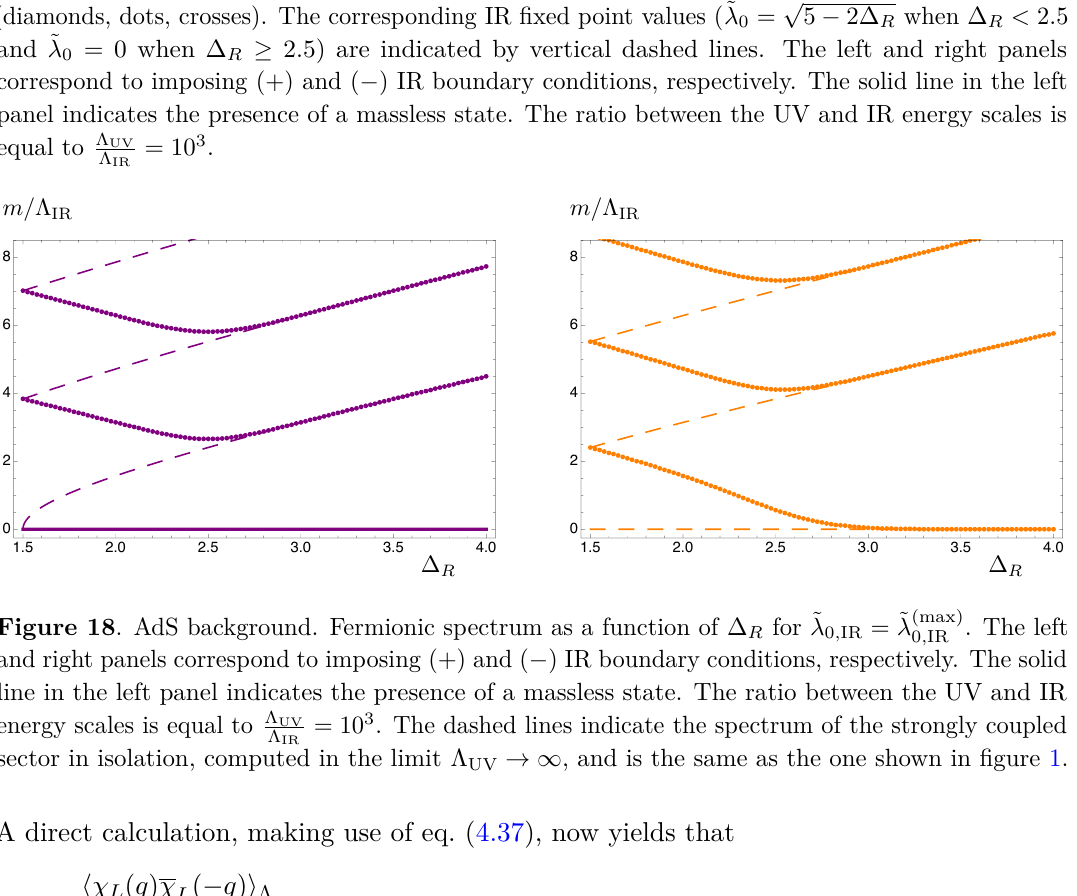
√ 5 − 2∆ R when ∆ R < 2 . 5